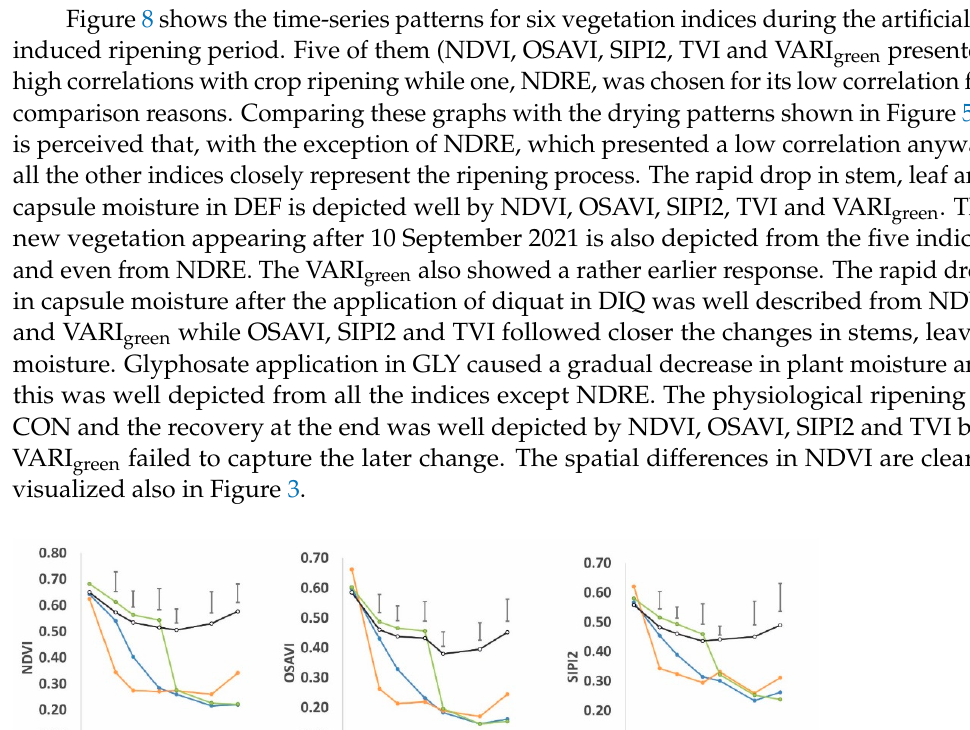
Figure 7. Relationship between moisture content of stems and leaves and moisture of capsules. Data from the whole monitoring period.